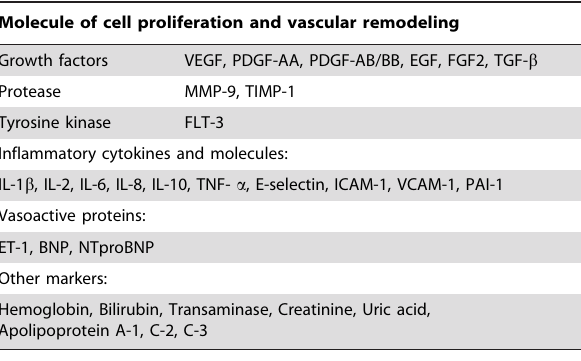
Table 1. List of investigated biomarkers.